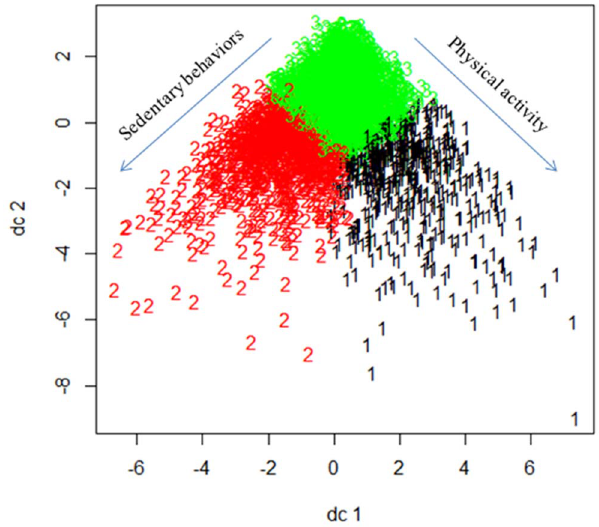
Figure 1. Plot of all participants by clusters on the first two discriminant components, dc1 (representing physical activity at Waves I and III and sedentary behaviors at Waves I and II) and dc2 (representing physical activity at Waves II and III and sedentary behaviors at Waves I and III).